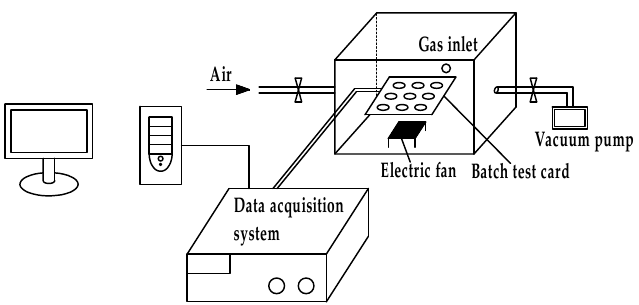
Figure 7. The test device diagram of the gas sensor.